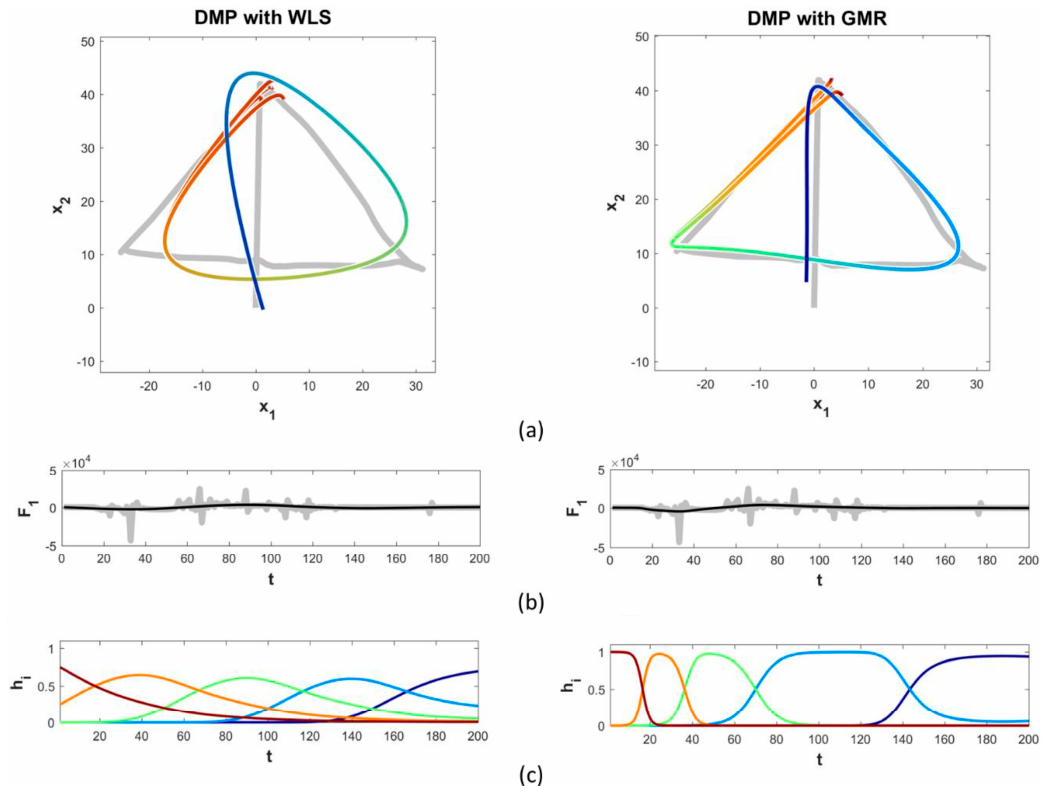
Figure 1. An example of DMP learning applied in trajectory: ( a ) A comparison of the reproduction accuracy of two motion learning systems (the rainbow overlays) for a two dimensional drawing (underneath, in gray), between WLS and GMR; ( b ) Grey bars represent the force components exerted when creating the original trajectory over time. Note that the forces are strongest when the trajectory forms each corner of the triangle. The activation states of Gaussian mixture regression (GMR) are automatically assigned based on the perturbation of the force on the system’s replication of the original trajectory; ( c ) The five activation states of each motion learning algorithm. Weighted least squares (WLS) activation states fire after equal intervals of time, whereas GMR activation states fire at corners, which are the defining portions of this particular